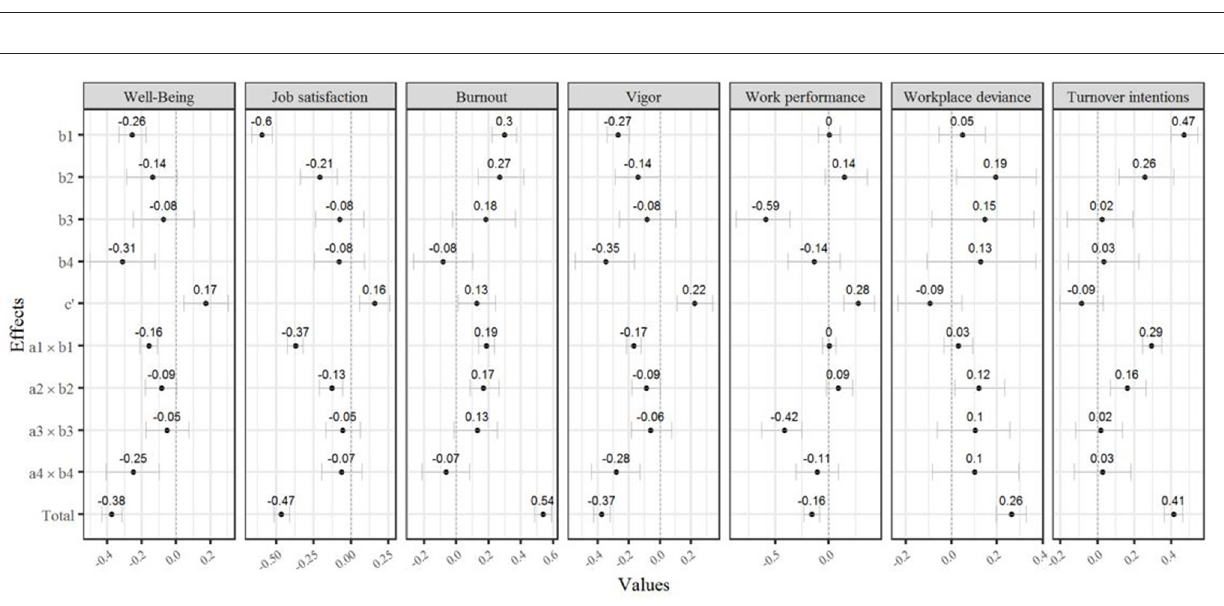
FIGURE 2 | Psychological contract violation and basic need frustrations as mediators between workspace bullying and outcomes. Standardized effects. Covariance among independent variables, item-level structure of the constructs, error terms, and correlations between error terms of dependent variables are not shown, for simplicity and clarity. CI 95 based on 10,000 bootstrap samples calculated with percentile bootstrap approach; R 2 Psychological contract violation = 0.39 ; R 2 Frustration autonomy = 0.39 ; R 2 Frustration Competence = 0.50 ; R 2 Frustration Relatedness = 0.64 .